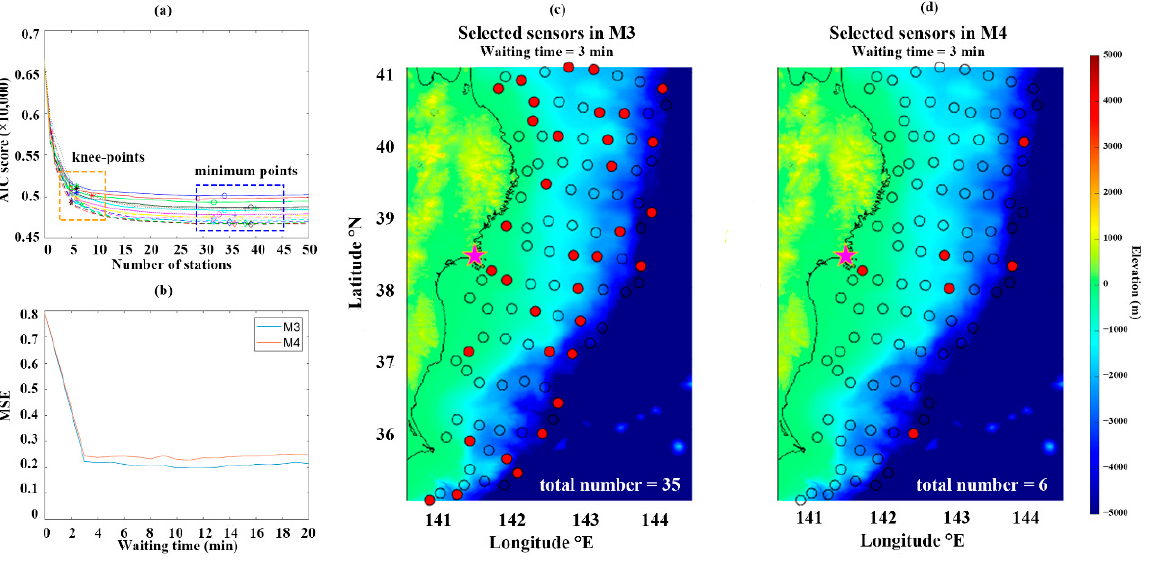
Figure 11. Results of the hazard-based early warning model for Onagawa: ( a ) AIC score plot, ( b ) MSE-waiting time plot, ( c ) optimal sensor map for M3, and ( d ) optimal sensor map for M4. The pink star represents the target location (Onagawa). The red and empty circles represent the selected and unselected sensors, respectively.